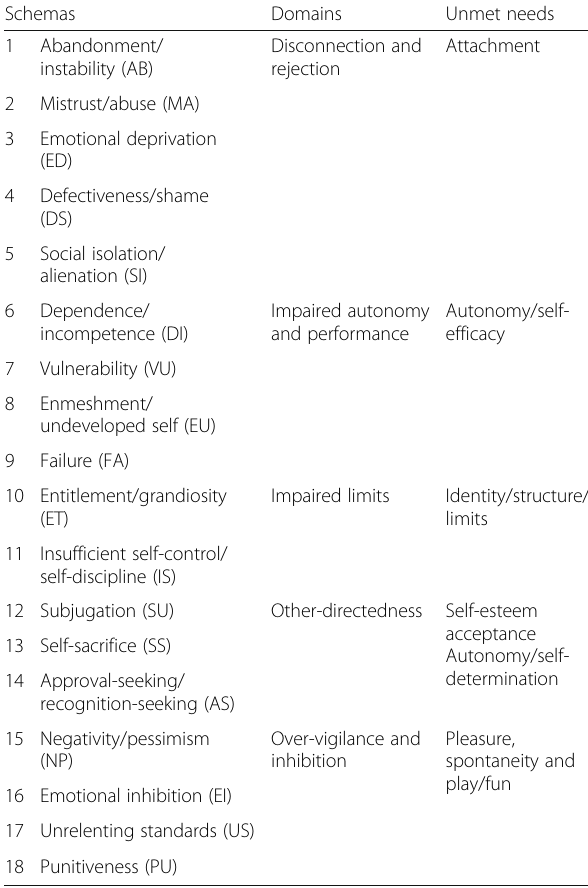
Table 1 Early maladaptive schemas and their correspondence to schema domains and unmet